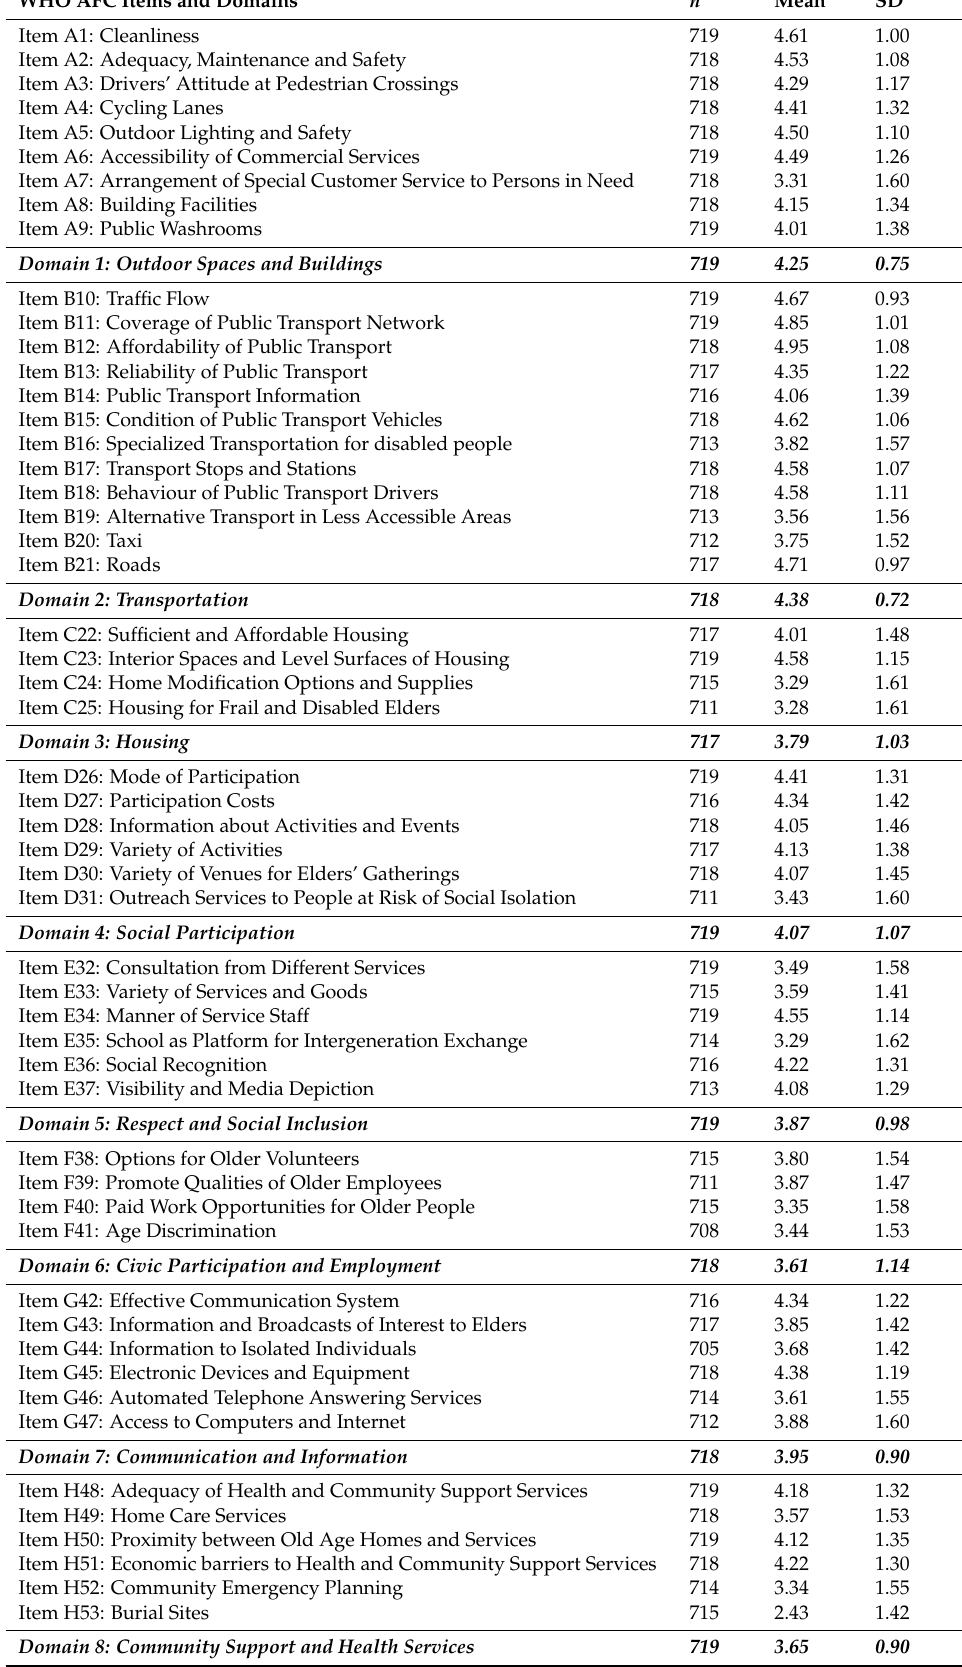
Table 2. Mean scores of the WHO AFC items and domains in Sha Tin and Tai Po. WHO AFC Items and